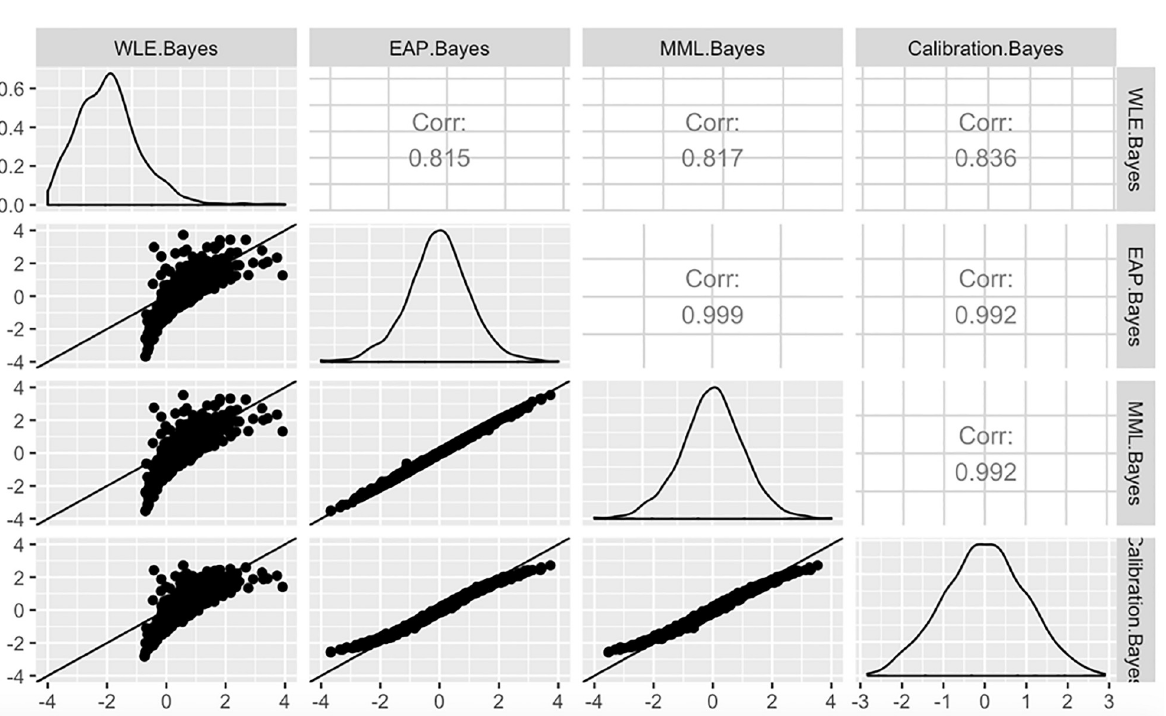
Fig 5. Pairwise comparison of scoring of the Basic Mobility (BM) scale calibrated using the full-Bayesian model. The methods compared are Warm’s weighted likelihood estimator (WLE), EAP, and MML. Calibration Bayes refers to the score inferred during item calibration.